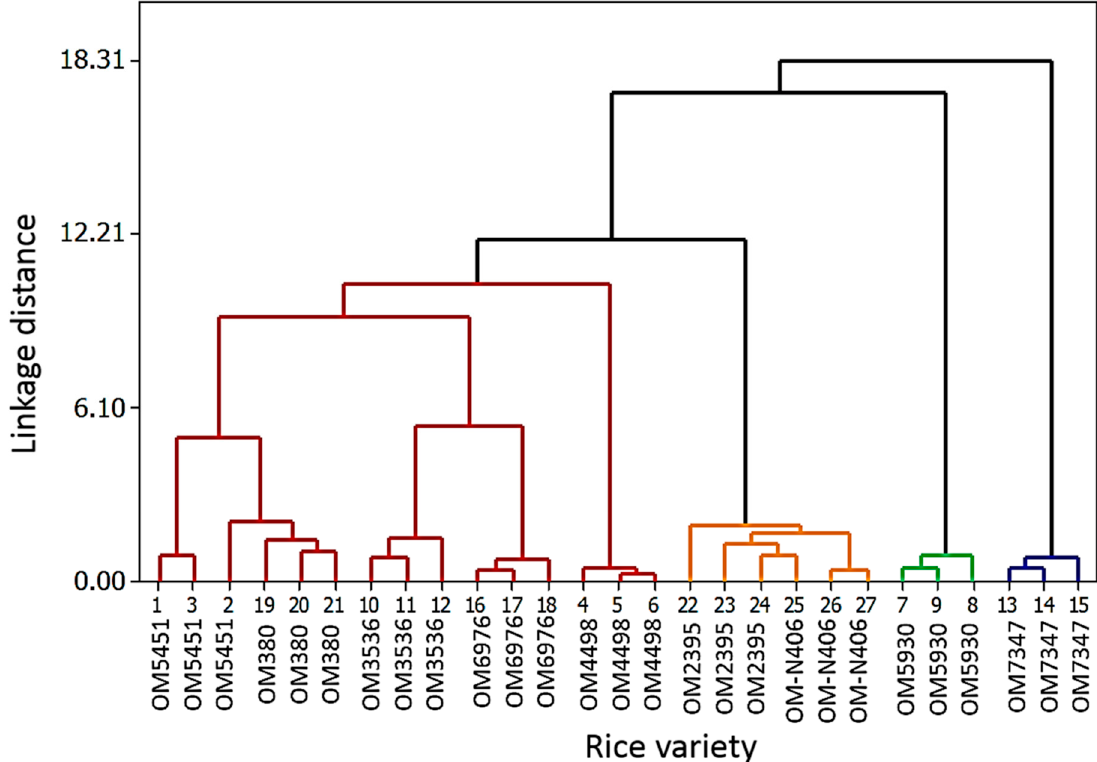
Figure 2. Dendrogram for the rice cultivars ((OM2395, OM5451, OM6976, OM380, OM5930, OM4498, OM3536, OM-N406, and OM 7347) from the hierarchical cluster analysis.